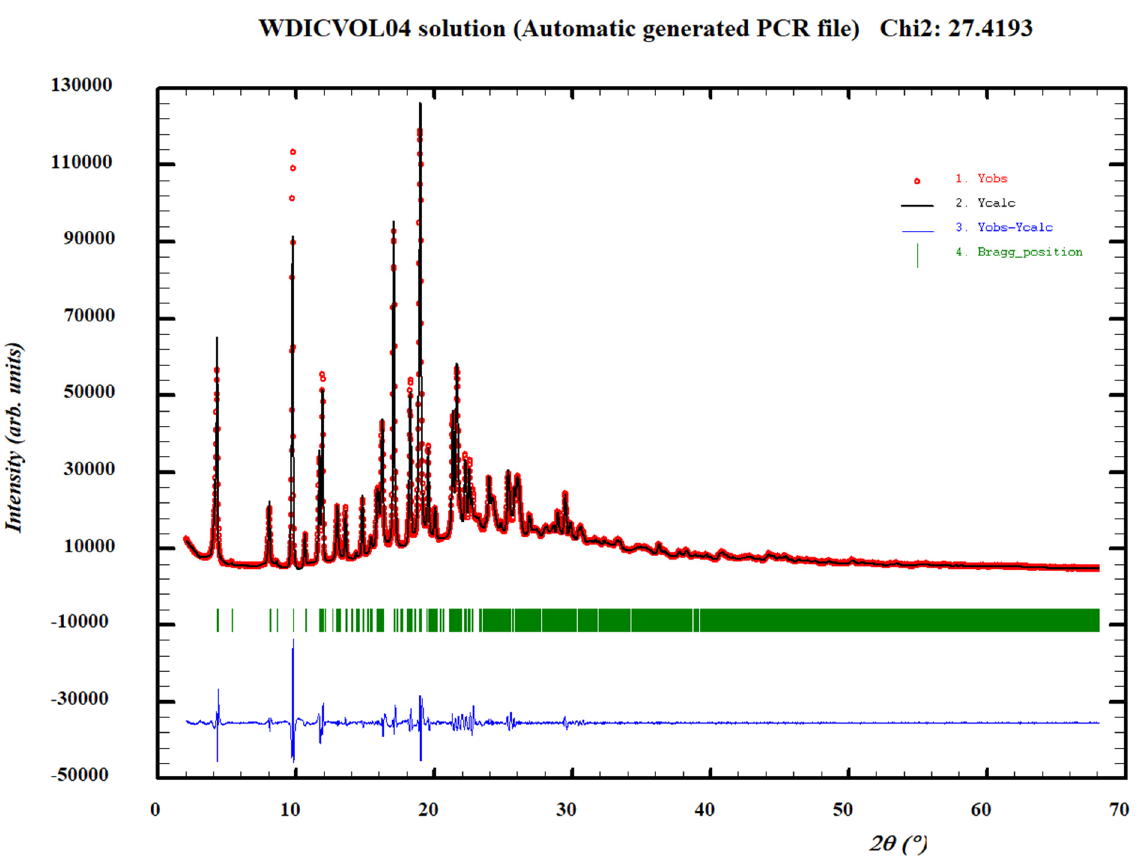
Figure 3. Pattern matching refinement of the AD–resorcinol cocrystal (Form I). Agreement factors: R wp : 5.06%; R exp : 0.97% (Chi-square: 27.42). Experimental XRPD profile (red marks), calculated XRPD profile (black solid line) and the difference between them (blue, line). Tick marks correspond to peak positions (|, in green).